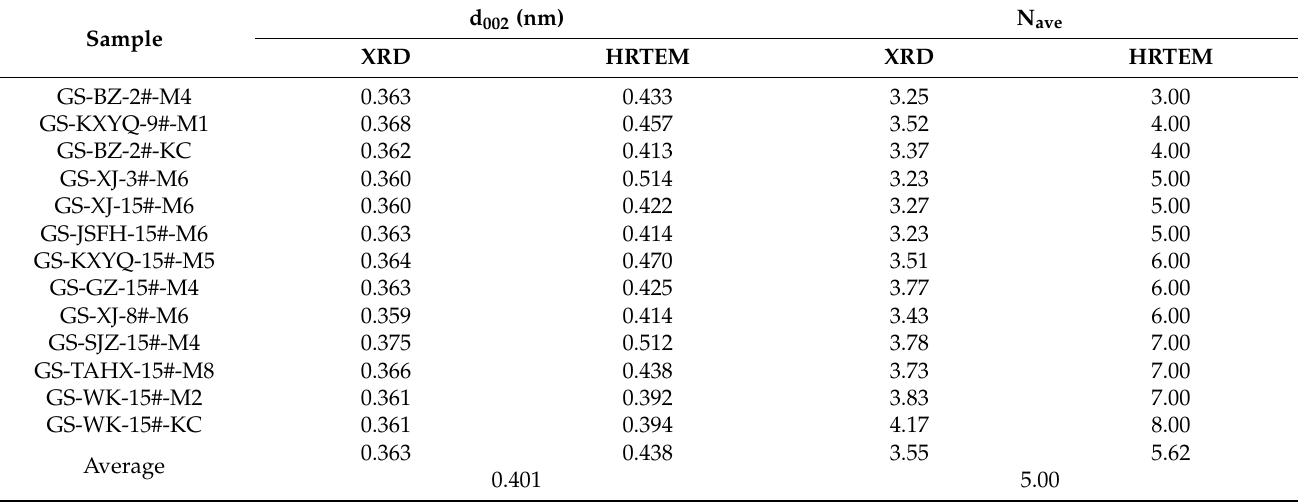
Table 9. Comparison of XRD and HRTEM characterization